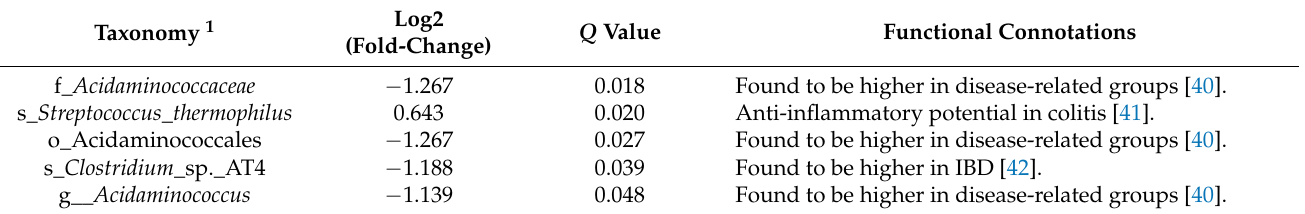
Table 7. Day 60 comparison of the taxonomic abundance of subjects demonstrating UV resistance following grape consumption on Days 30 and 60 ( n = 3) vs. subjects demonstrating resistance to UV irradiation following grape consumption only on Day 30 ( n = 6).